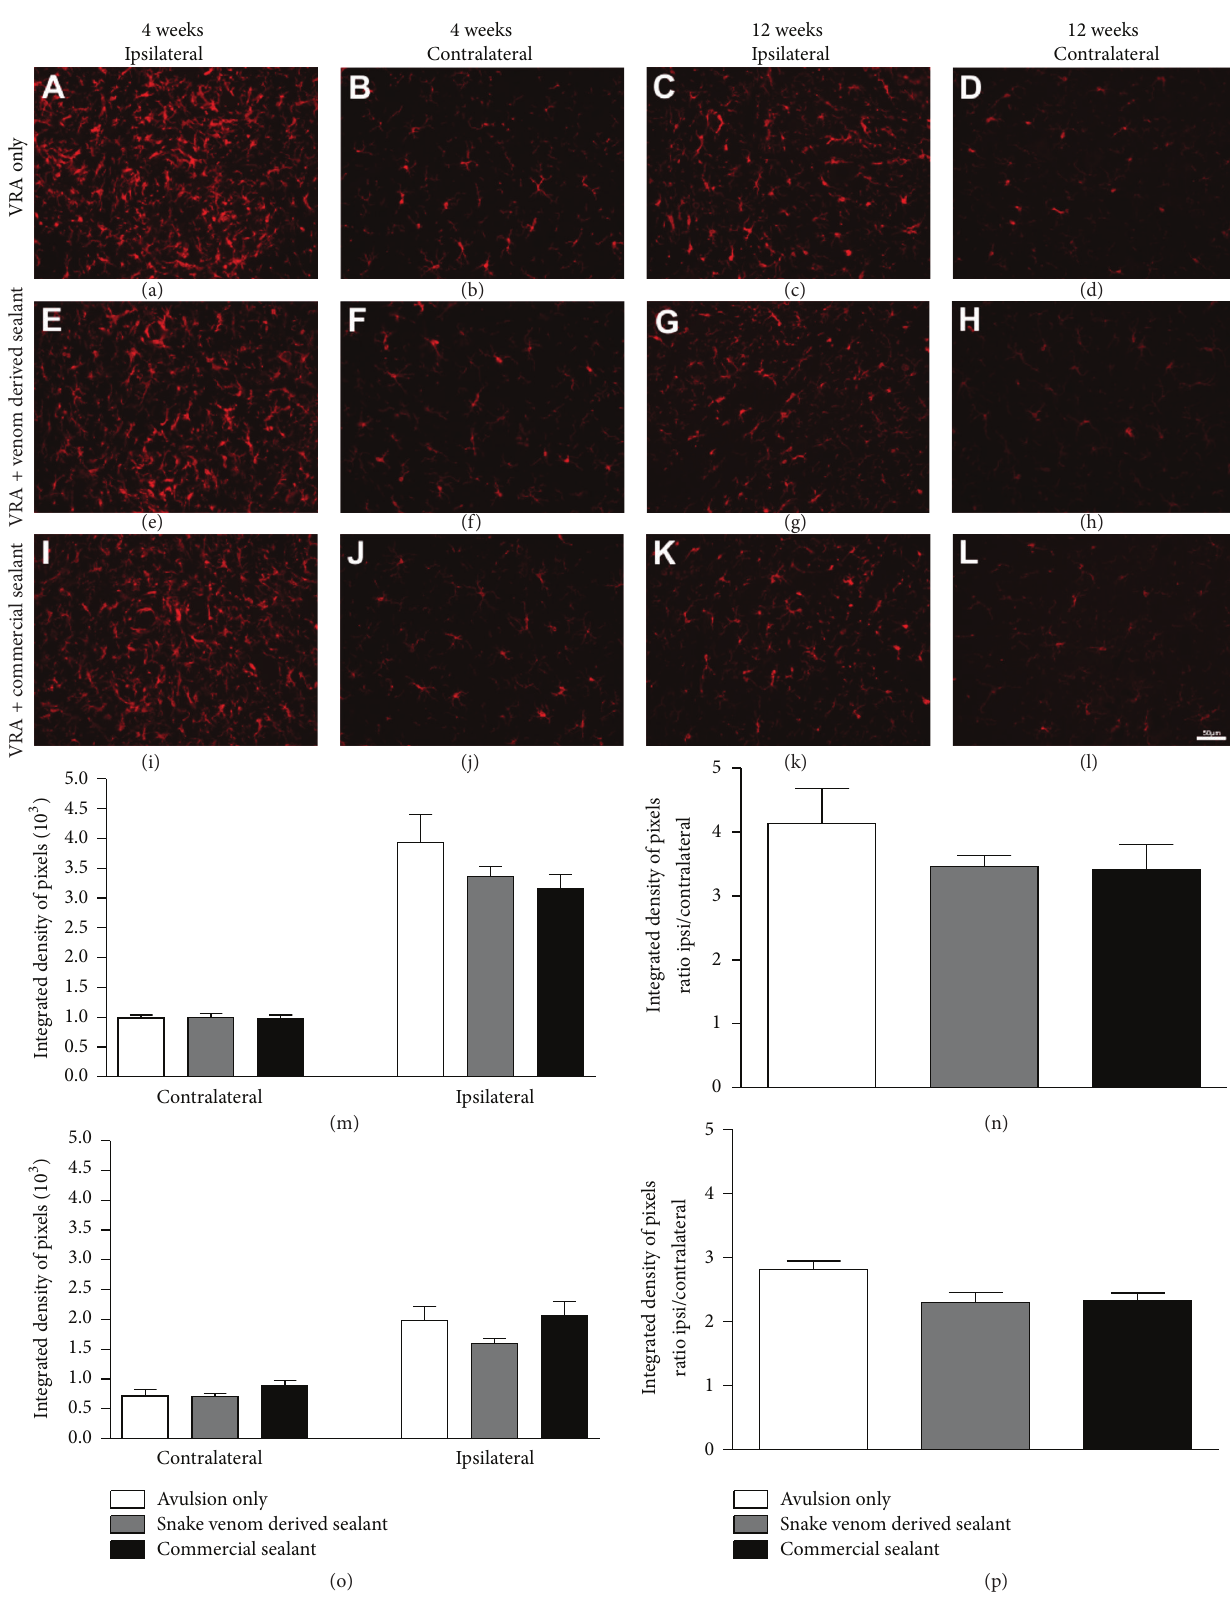
Figure 4: Immunohistochemical analysis of the spinal cord ventral horn stained with ionized calcium binding adaptor protein (Iba1), 4 and 12 weeks following ventral root avulsion and repair. No significantly further increase in microgliosis after reimplantation was observed. (a-b, e-f, and i-j) Ipsilateral and contralateral sides, 4 weeks after lesion. (c-d, g-h, and k-l) Ipsilateral and contralateral sides, 12 weeks after lesion. (m) Mean integrated density of pixels obtained ipsi and contralateral to the lesion side, 4 weeks after injury. (n) The ratio IL/CL (ipsi/contralateral sides) of the integrated density of pixels at lamina IX, 4 weeks after lesion. (o) Mean integrated density of pixels obtained ipsi and contralateral to the lesion side, 12 weeks after injury. (p) The ratio IL/CL (ipsi/contralateral sides) of the integrated density of pixels at lamina IX, 12 weeks after lesion. Scale bar = 50 𝜇 m. Mean ±